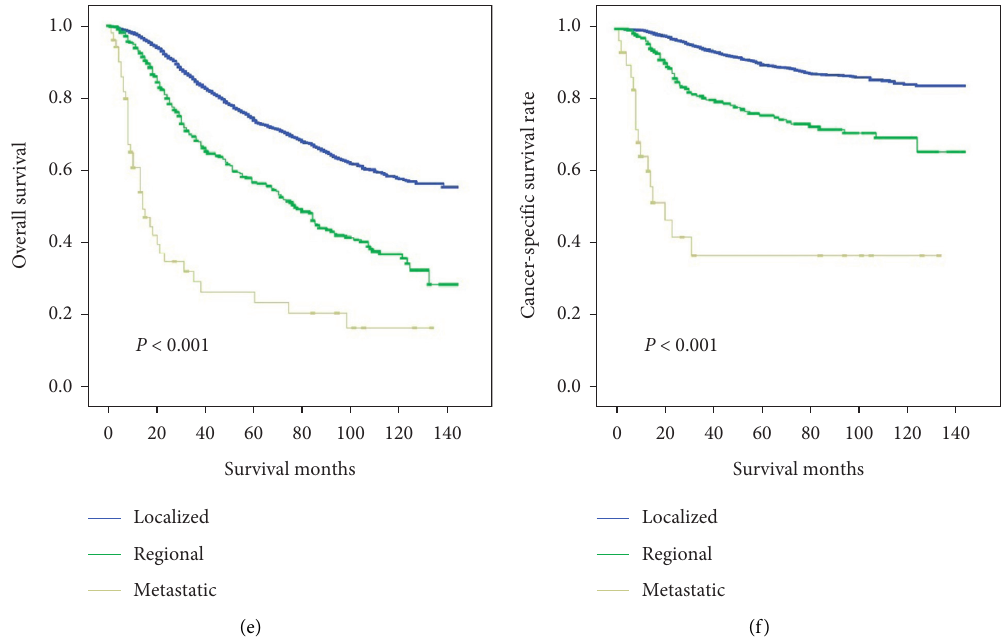
Figure 2: Kaplan–Meier comparison of overall survival (OS) and cancer-specific survival (CSS) (a, b) among patients with married, single, divorced or separated, and widowed status, (c, d) among patients with different genders, and (e, f) among patients stratified by SEER